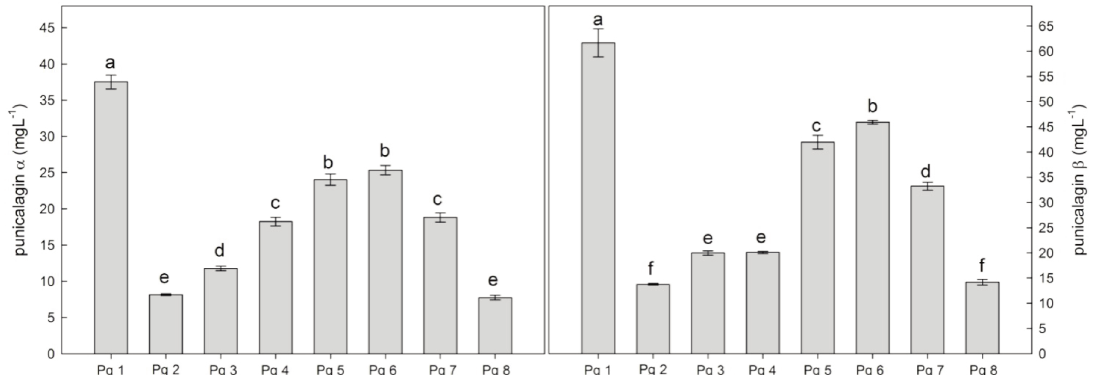
Fig. 3 ­ Concentration of punicalagin α and β in the juices obtained from pomegranate fruits harvested in each sampling area. The bars indicate the standard deviation (n=3). Different lowercase letters indicate significant differences according to Tukey’s test (p ≤ 0.05).